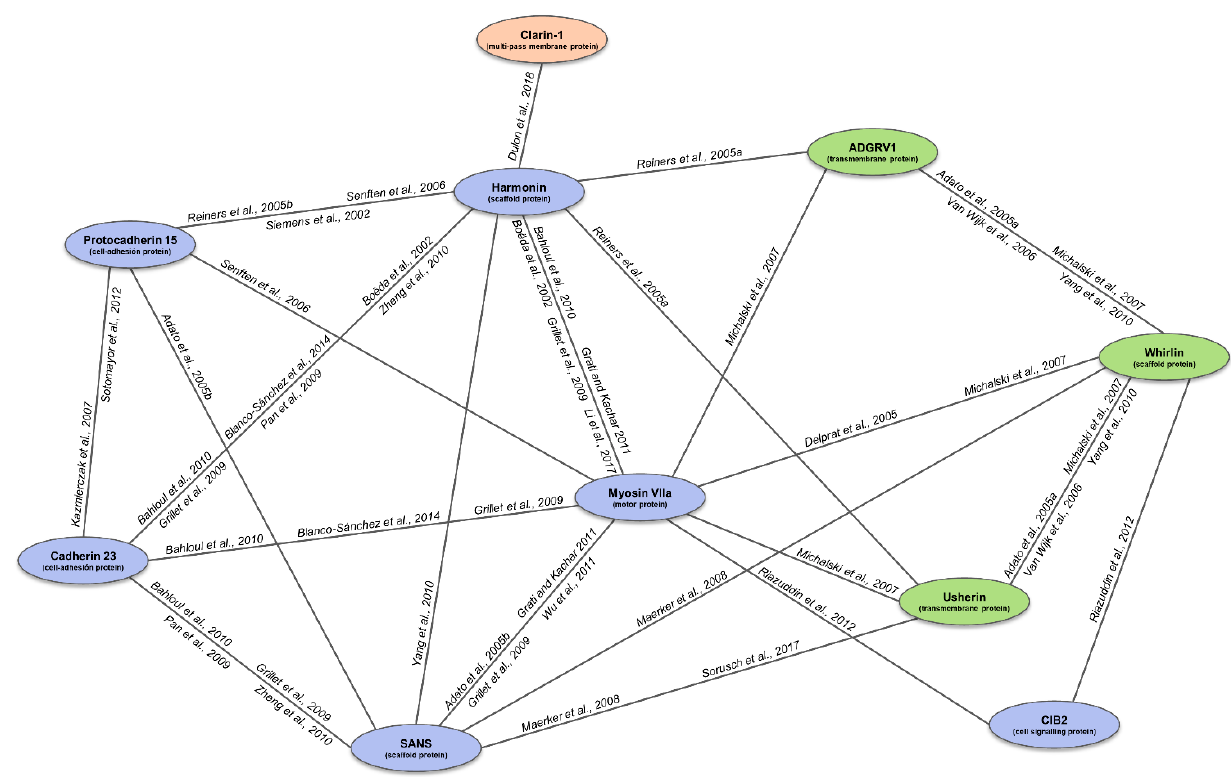
Figure 1. Representation of the USH interactome and supporting literature. The connecting lines represent the detected interactions between the USH1 (blue), USH2 (green) and USH3 (orange) proteins, according to the in vitro and in vivo studies to date (specified next to the lines). Adapted figure from Fuster García (2020). References figure: [10,92,106–108,138–142] [25,26,28,29,143–145] [61,146–148].